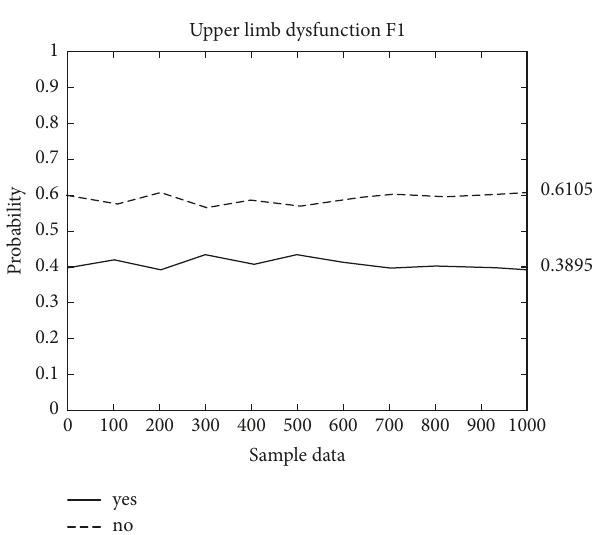
Figure 10: The parameter learning process of F 1